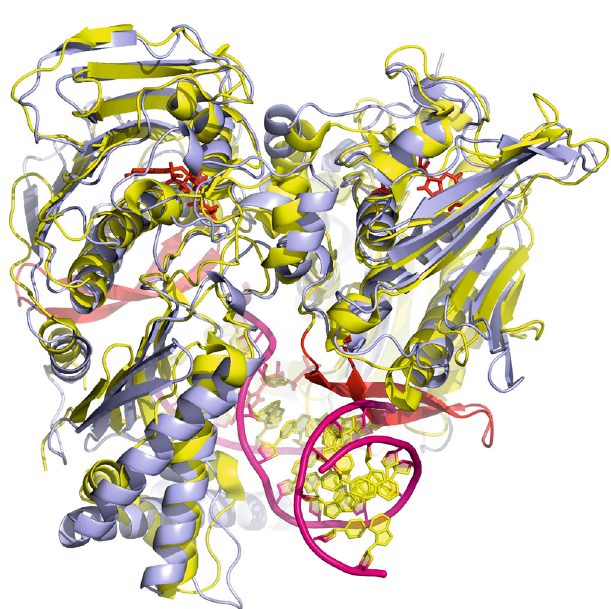
Fig. 8 Overlap between the dimerized yeast topoisomerase II ATPase domain (Protein Data Bank 4GFH]) 31 (shown in yellow) and S. pneumoniae topoisomerase IV ATPase domain (through-hole DNA bound complex; shown in blue). AMP-PNP molecules are shown in red, and DNA is shown in pink/yellow for backbone/bases, respectively. The additional eukaryotic topo II-speci fi c loop is shown in red. The structure indicates a potential clash between the bound DNA and the 22-amino acid long insertion loop in the eukaryotic topoisomerase II structure (Supplementary Fig.